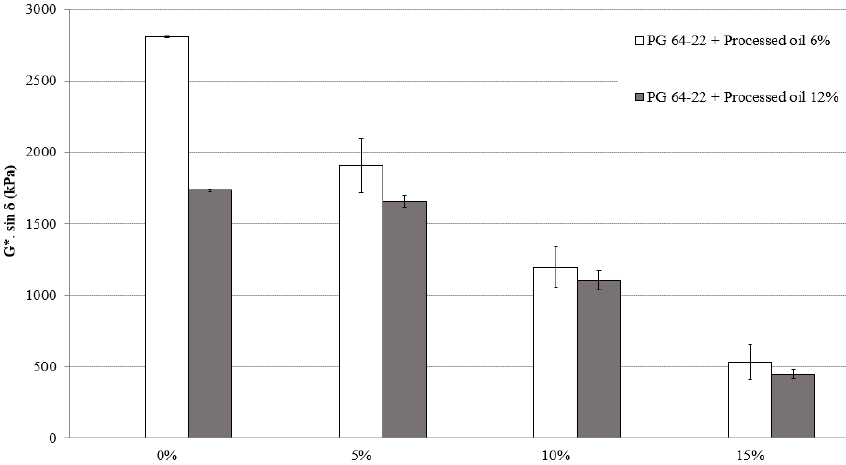
Figure 6. G*sin δ of RTFO + PAV aged PG 64-22 binders with processed oil as a function of SBS content at 25 °C.